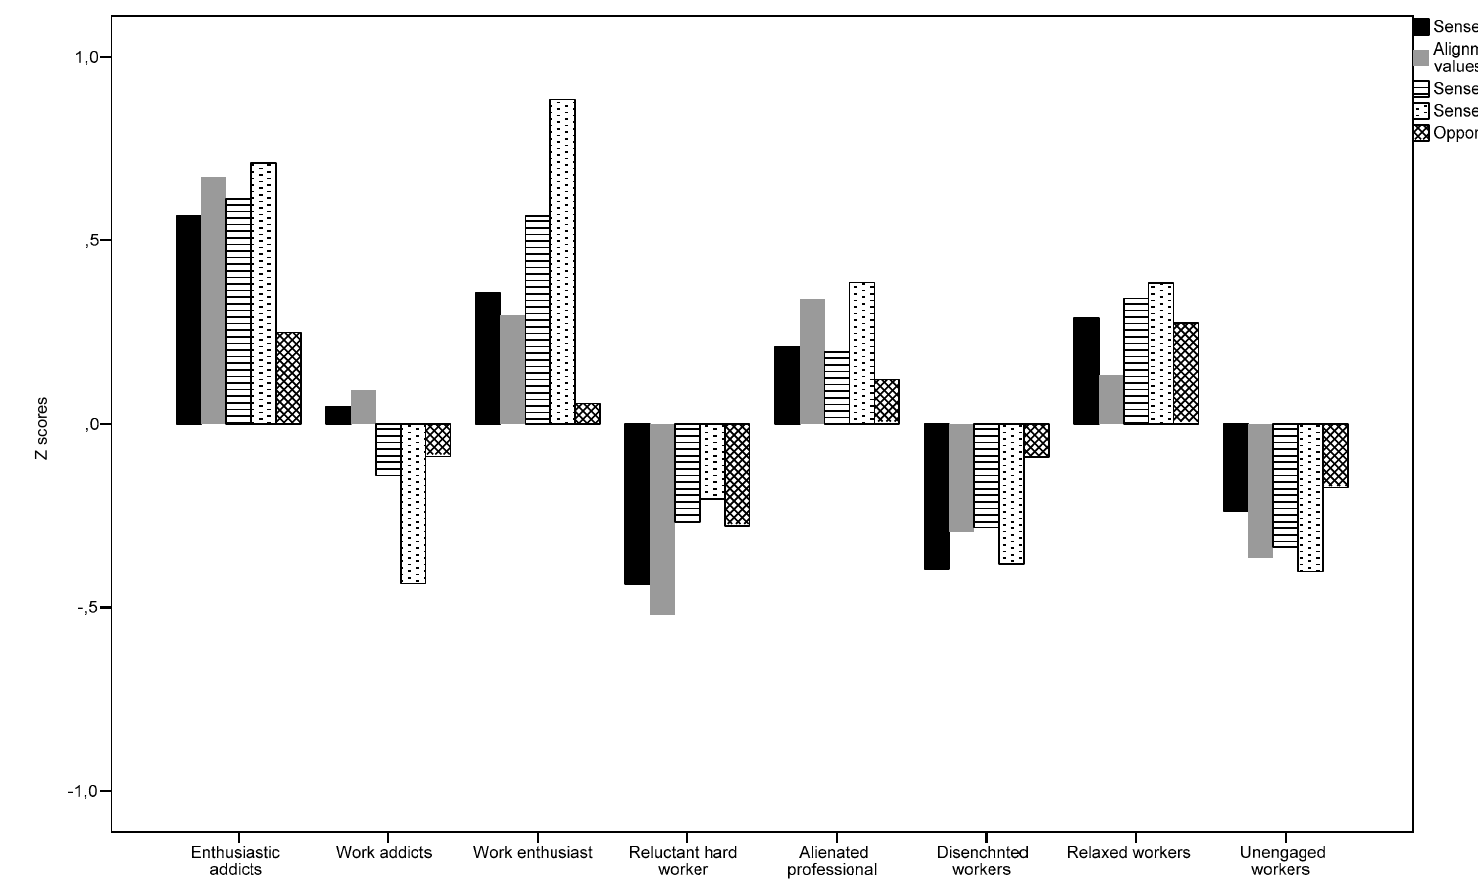
Figure 1. Workplace Spirituality dimensions in each worker profile: standardized scores.